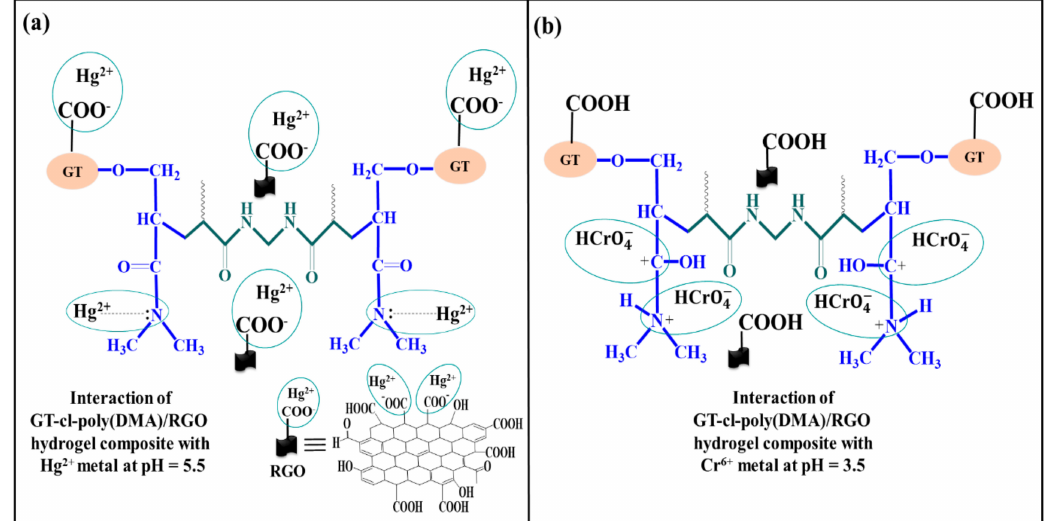
Figure 6e,f. The adsorption percentage was increased by increasing the adsorbent dosage. This was due to the existence of more adsorption sites with enhanced dose of adsorbent. The removal e ffi ciencies + of Hg 2 were found to be 86.4% and 98.4% by GT-cl-poly(DMA) hydrogel and GT-cl-poly(DMA) / RGO hydrogel composite correspondingly at dose of 0.035 g. The reported Cr 6 were 77.2% and 82.3% by using GT-cl-poly(DMA) hydrogel and GT-cl-poly(DMA) / RGO hydrogel composite respectively at optimized dose of 0.045 g. Thus, 0.035 g (for Hg 2 were the ideal doses used for